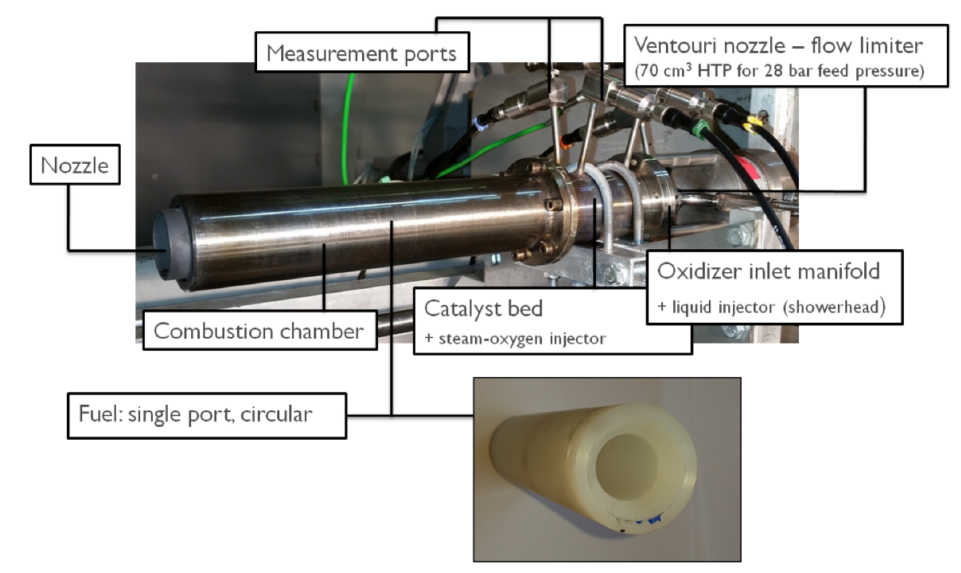
Figure 3. Laboratory hybrid rocket motor for fuel regression characterization, circa 100 N of